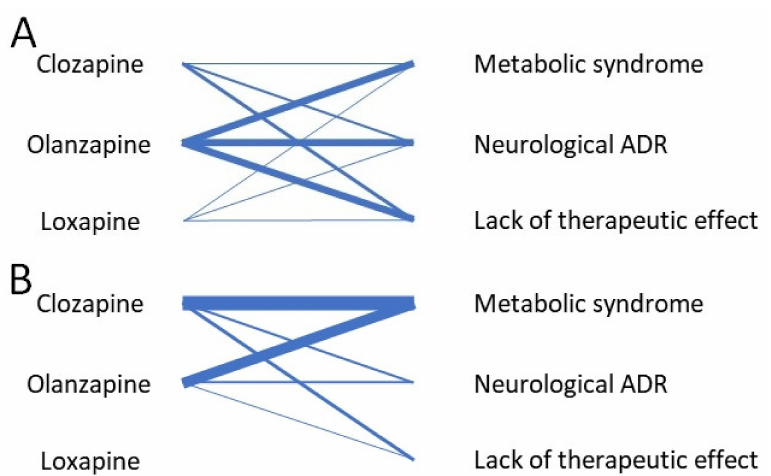
Figure 2. ( A ) Network diagram for pediatric pharmacogenetic studies regarding CYP1A2- metabolized AP and their adverse drug reactions. ( B ) Network diagram for mixed population pharma- cogenetic studies regarding CYP1A2-metabolized AP and their adverse drug reactions. The thickness of the connecting lines corresponds to the number of studies evaluating the drug–ADR